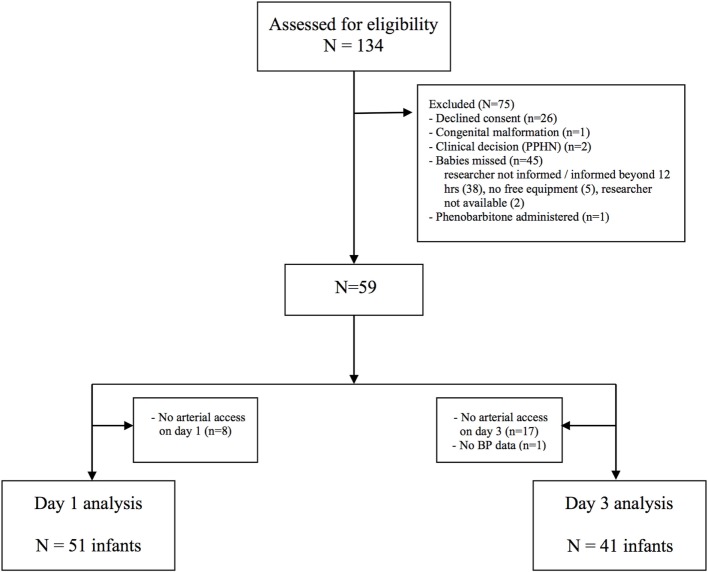
CONSORT diagram of recruitment of preterm newborns to the study.